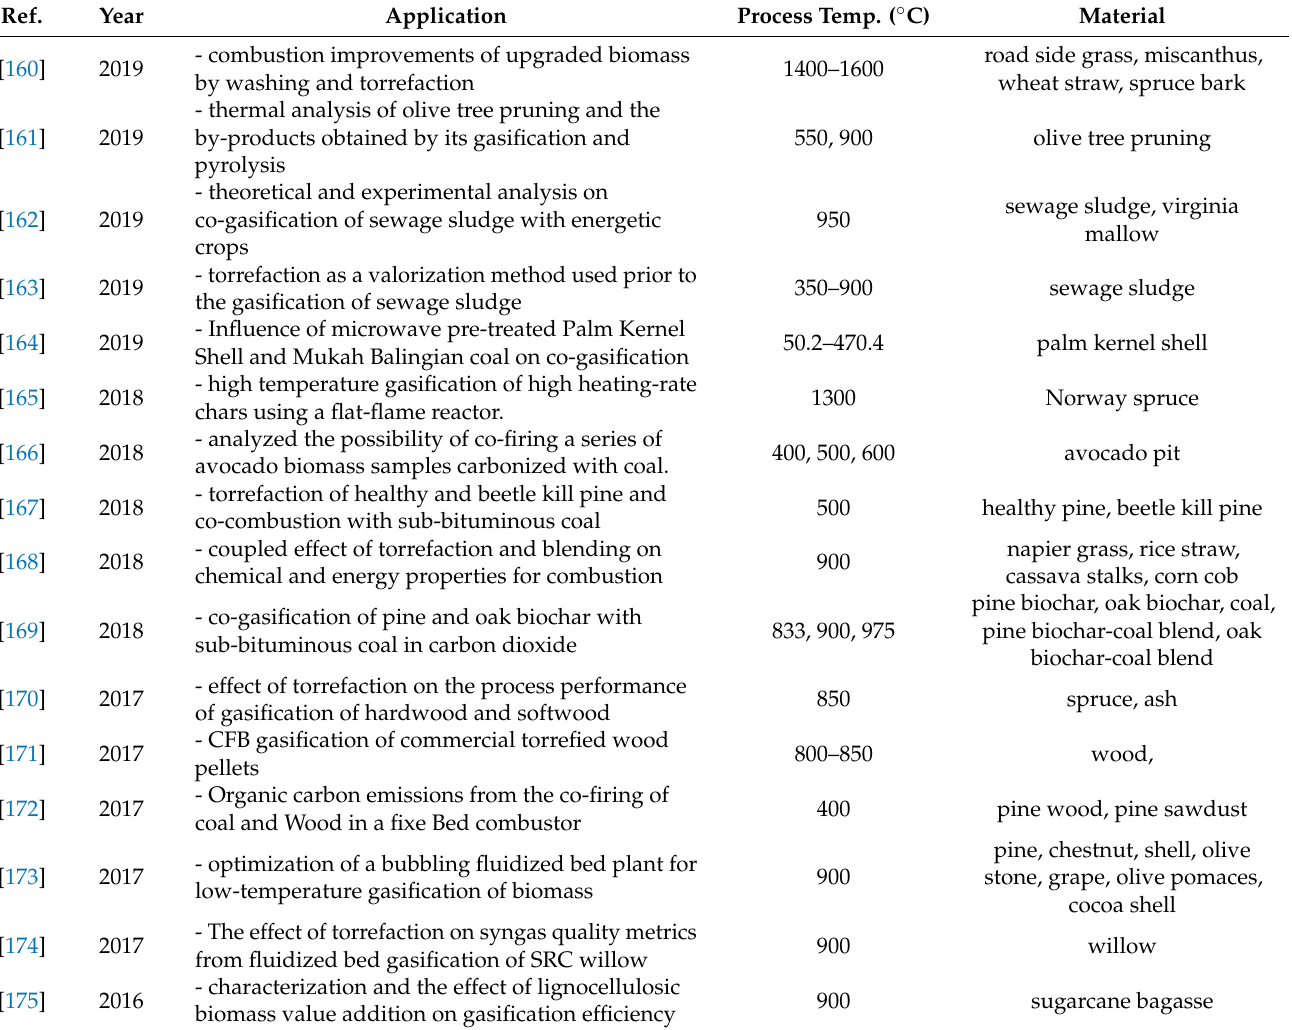
Table A4. The use of torrefied biomass in the gasification and co-combustion process—detailed thematic analysis.